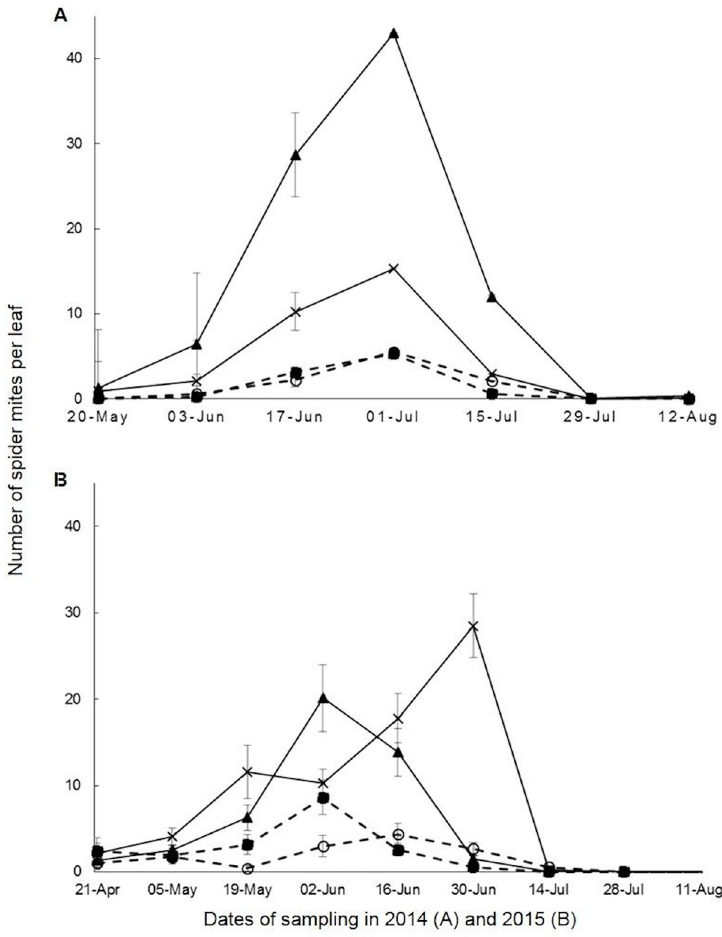
Fig 2. Numbers of Tetranychus urticae per strawberry leaf plotted against time in 2014–2015 experiments. Treatments in (A) Blackberry Field in 2014 (20 May–12 August) and in (B) Pheasant Field in 2015 (21 April–11 August) were: untreated control , commercial fungicide only , 0.017% silicon nutrient (by volume) alone applied once a week without commercial fungicide) , 0.017% silicon nutrient (by volume) applied once a week, plus commercial fungicide . Vertical axis indicates average number of T . urticae counted per strawberry leaf of 75 leaves sampled from each treatment. Horizontal axis shows dates of sampling with a total of 7 (in 2014) and 9 (in 2015) samplings during the experimental period. AUPPC values refer to Table 2. Error bars represent standard errors of means of five